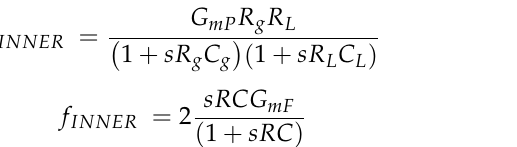
where C = C1 = C2, v test represents the test voltage applied to the loop after breaking it at the point indicated in Figure 4a, and v measure is the voltage outputted by the loop there.